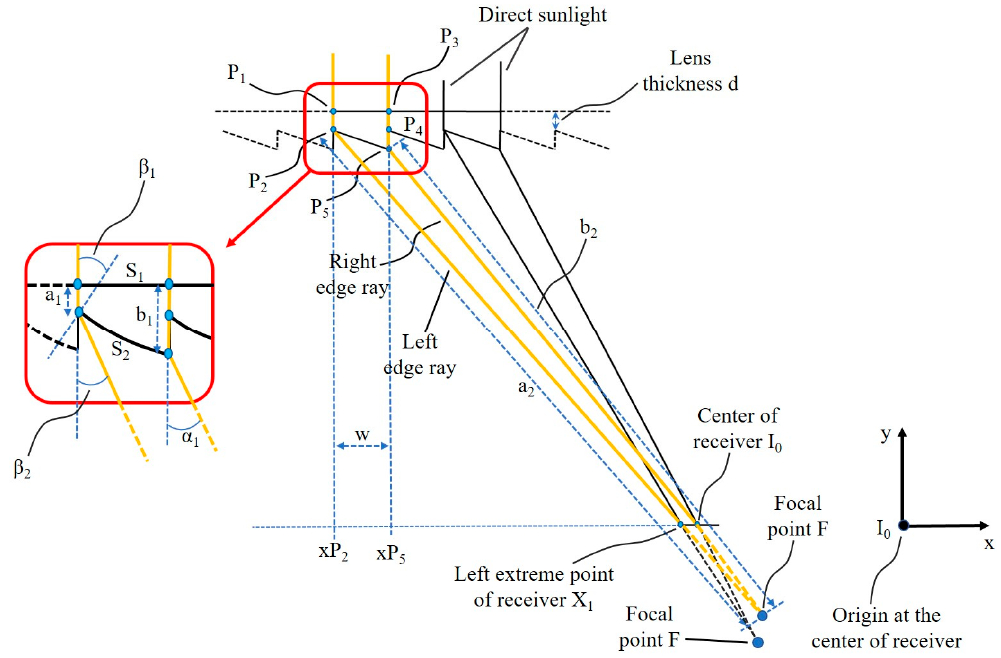
Figure 10. The distribution of direct sunlight in each groove of the linear Fresnel lens as a lower groove surface.